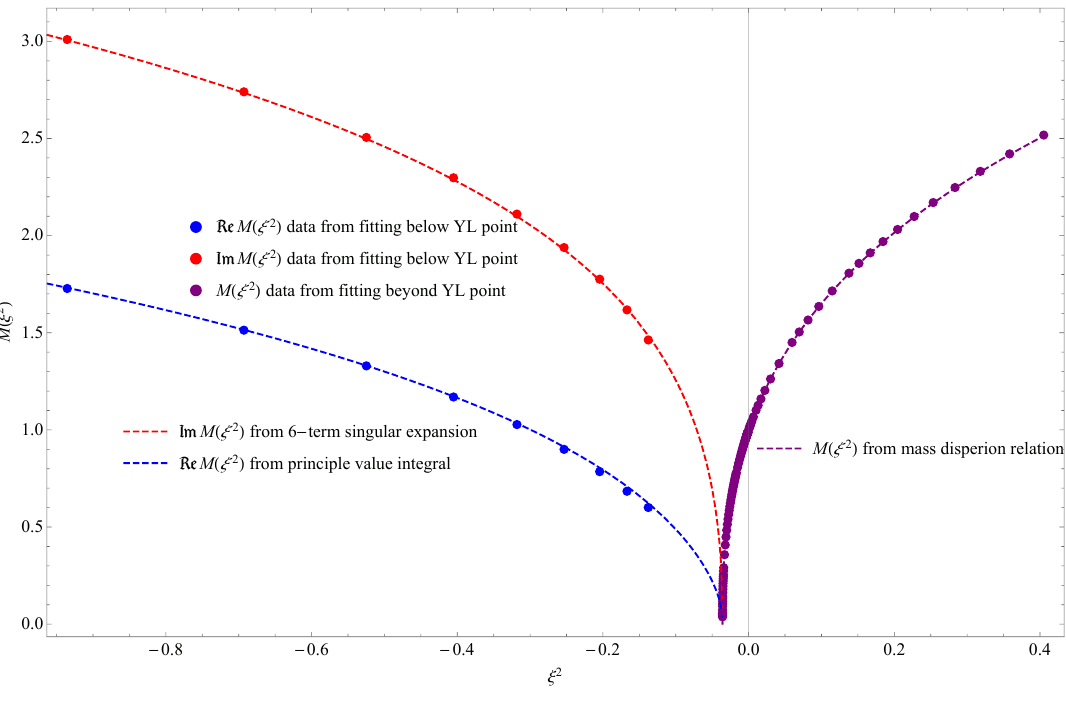
Figure 18 . Summary of the plots of M ( ξ 2 ) from measurement and dispersion